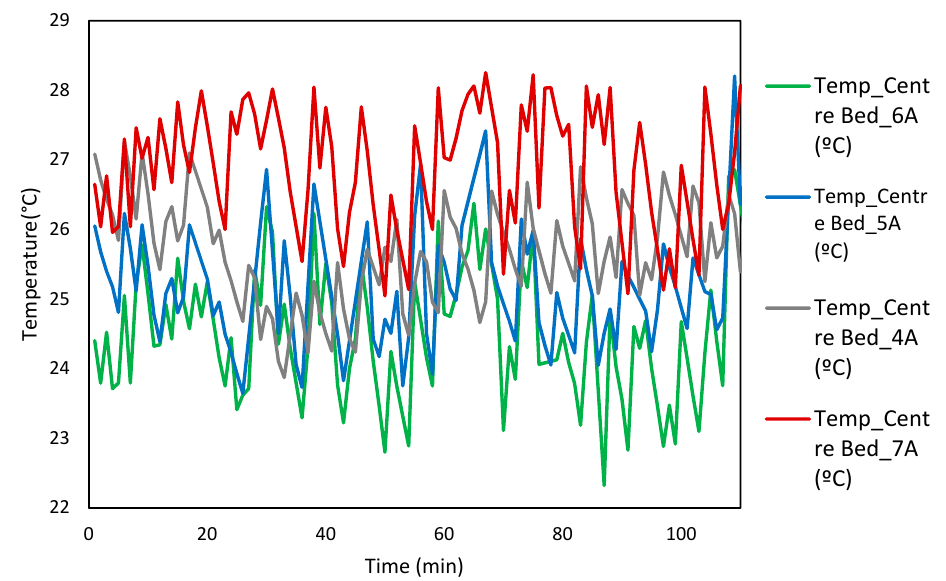
temperature and relative humidity was statistically significant when compared between operating power levels of 360 W (M = 26.22 +/ − 0.75 °C, M = 68.21 +/ − 2.31%) and 480 W (M = 25.65 +/ − 0.75 °C,